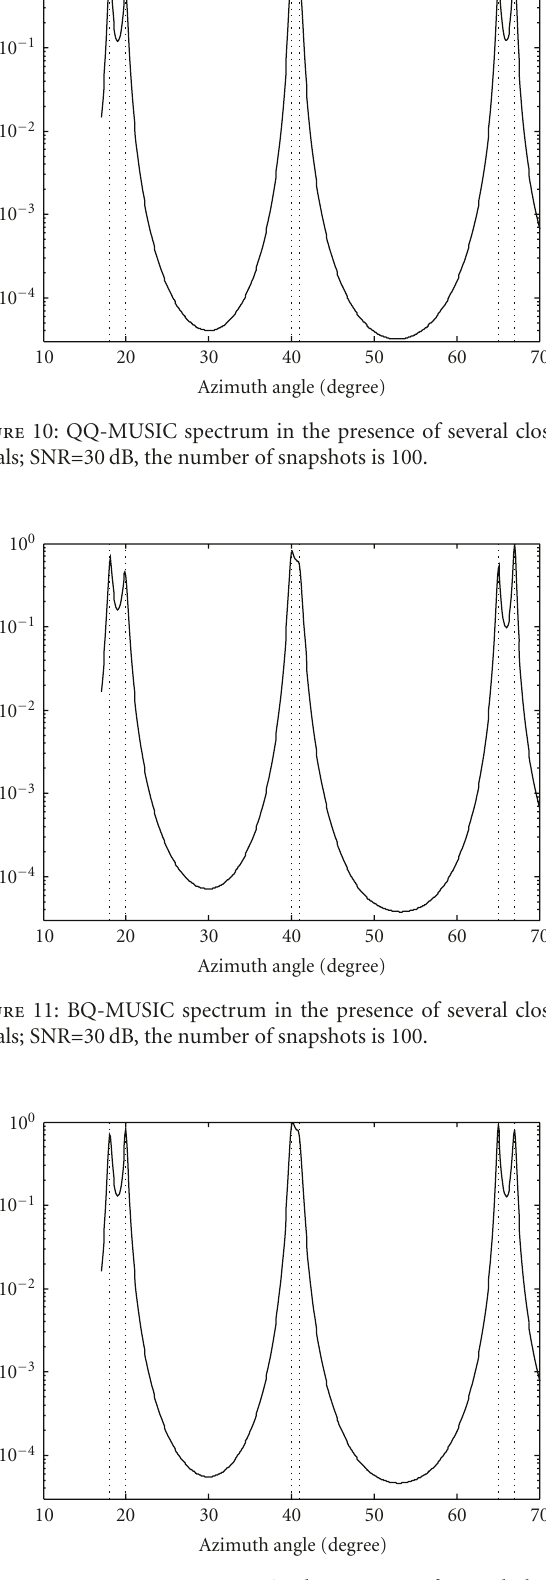
Figure 12: LV-MUSIC spectrum in the presence of several close signals; SNR = 30dB, the number of snapshots is